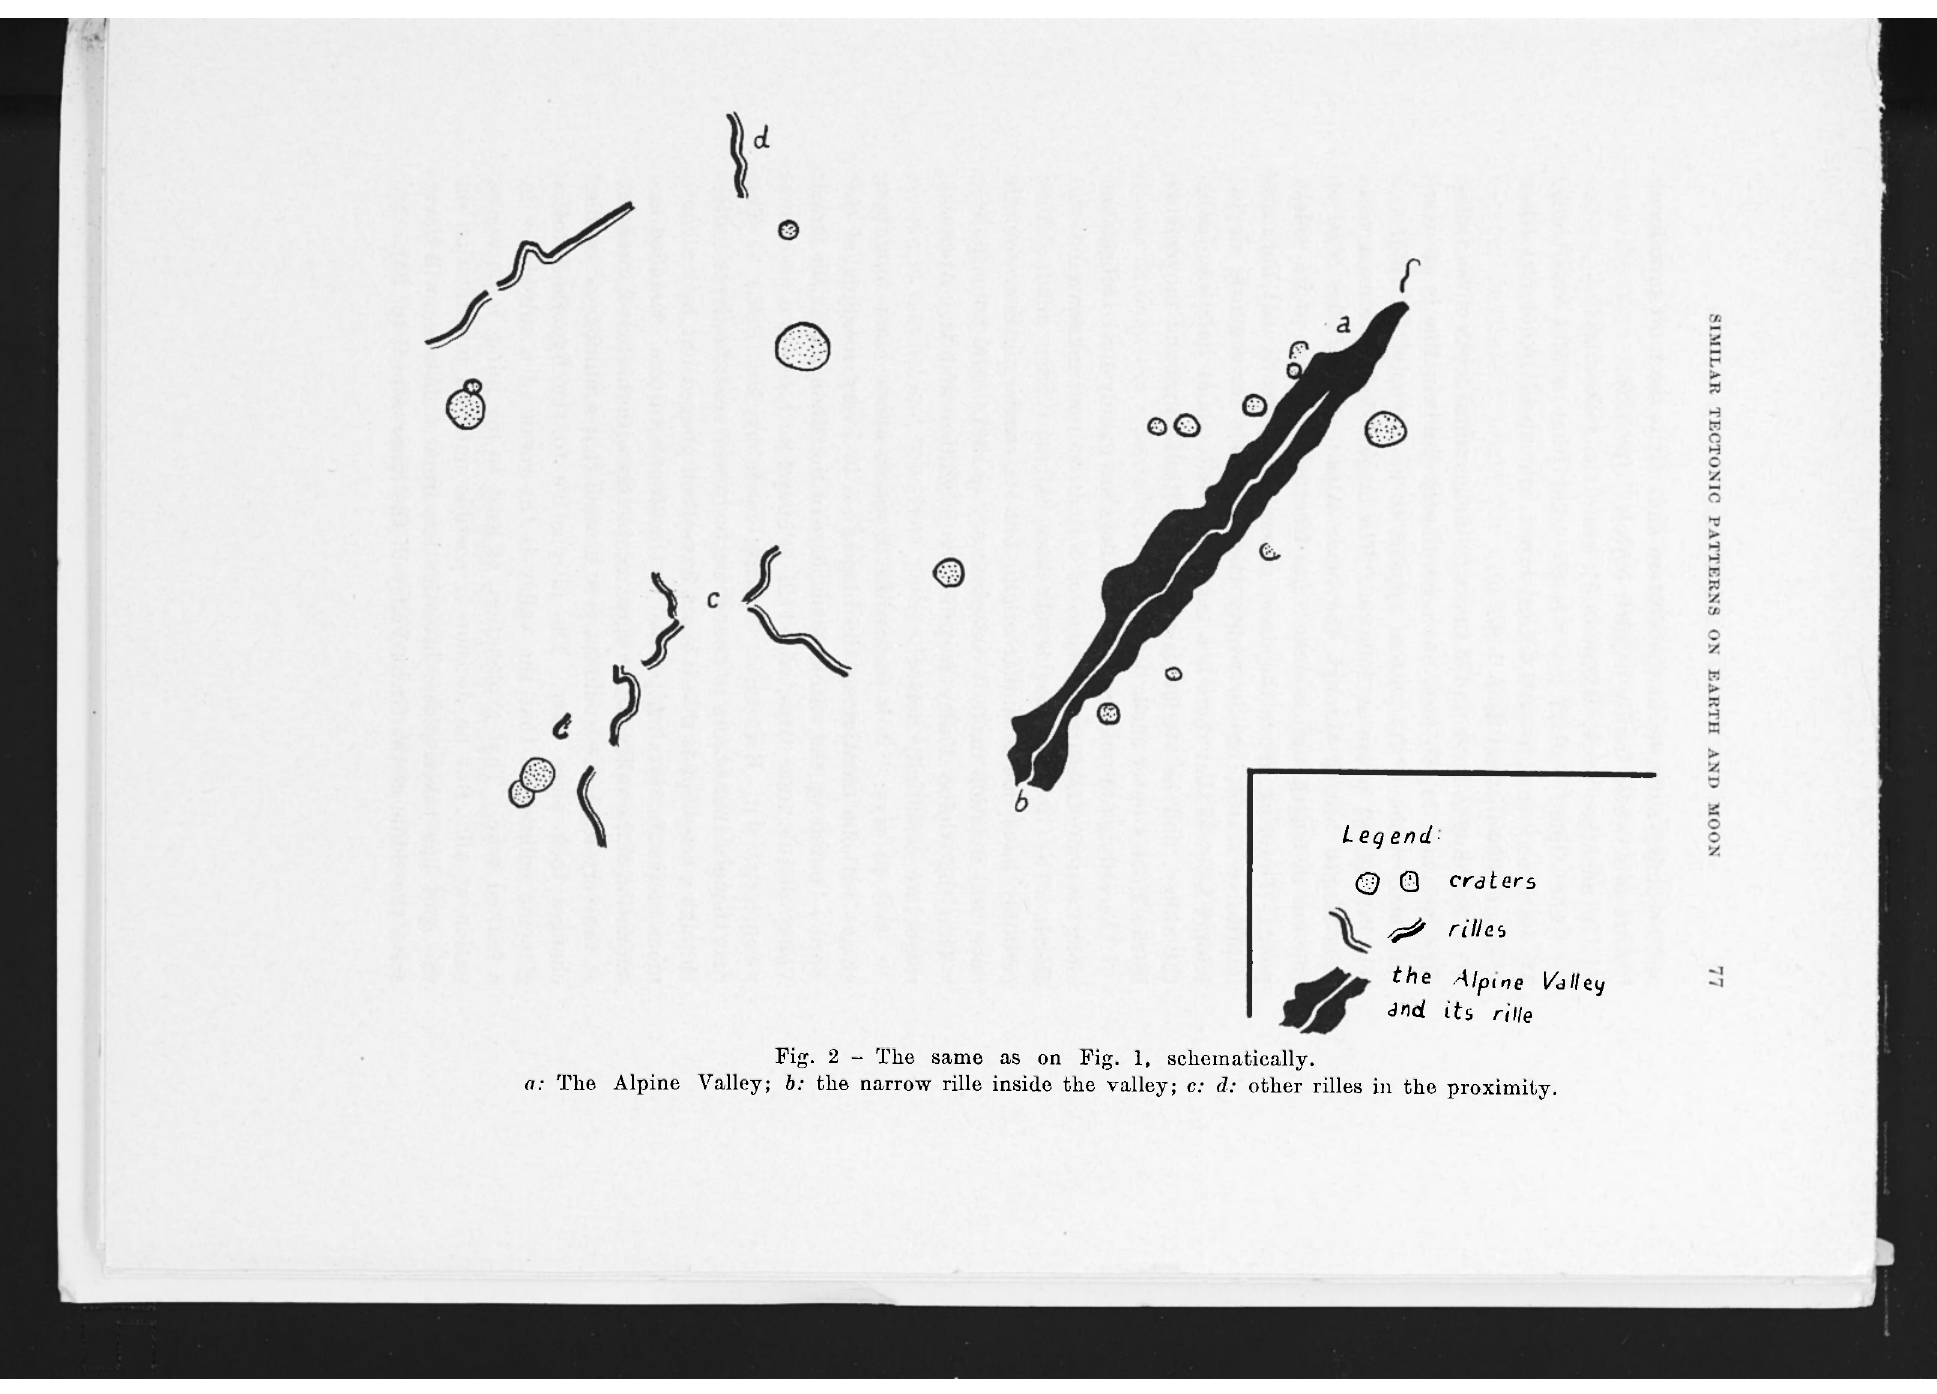
Fig. 2 - The same as on Fig. 1,